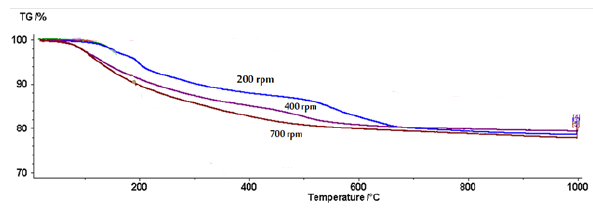
Figure 3: TGA patterns of kaolin–(NH 4 ) 2 HPO 4 sample mixture milled for 120 min at different milling speeds